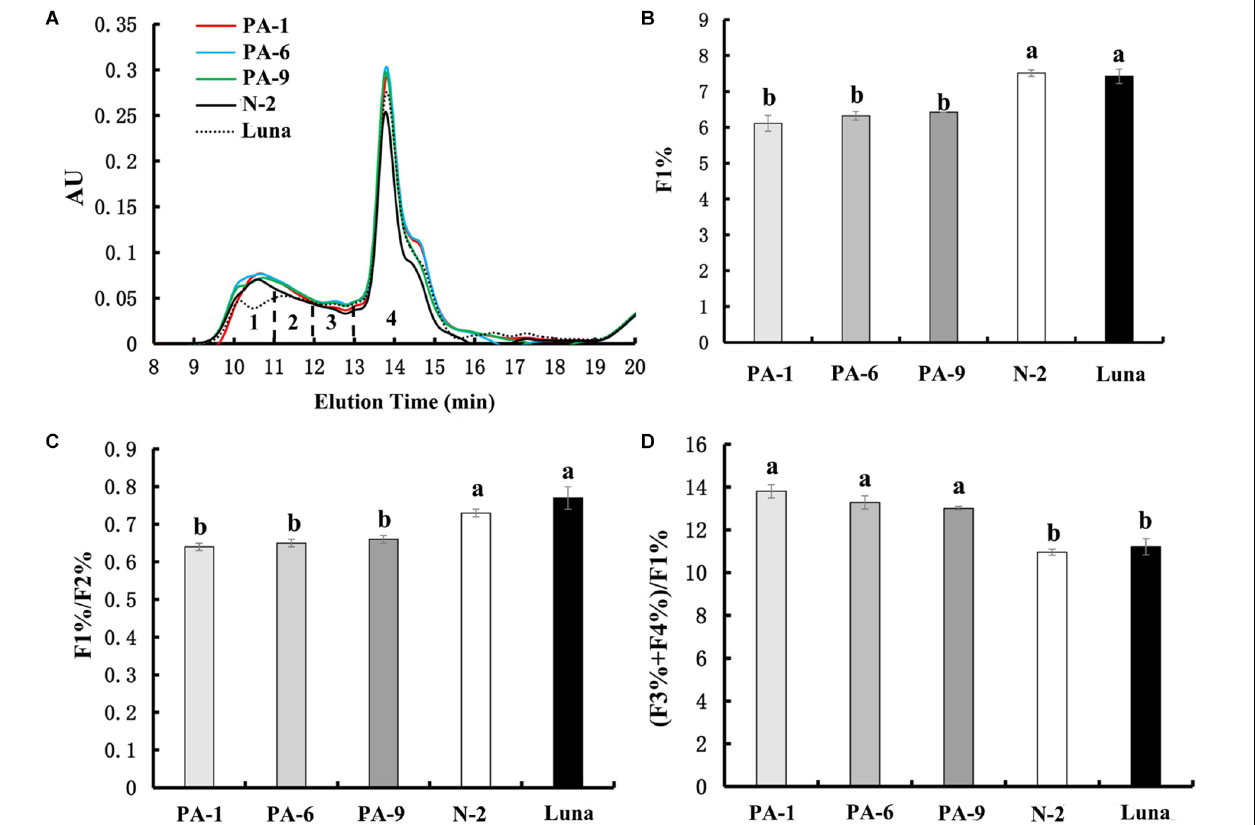
FIGURE 4 | Effect of PINA on the formation of gluten aggregates. (A) SE-HPLC analyses of flour samples from the transgenic and control lines. (B–D) Comparisons of the three SE-HPLC parameters F1%, F1/F2%, and (F3+F4%)/F1% between transgenic and control lines, which are related to gluten strength and baking quality. Data are given as mean ± SEM from three replicates. Different letters on the columns within the same SE-HPLC parameters indicate significant difference ( P <